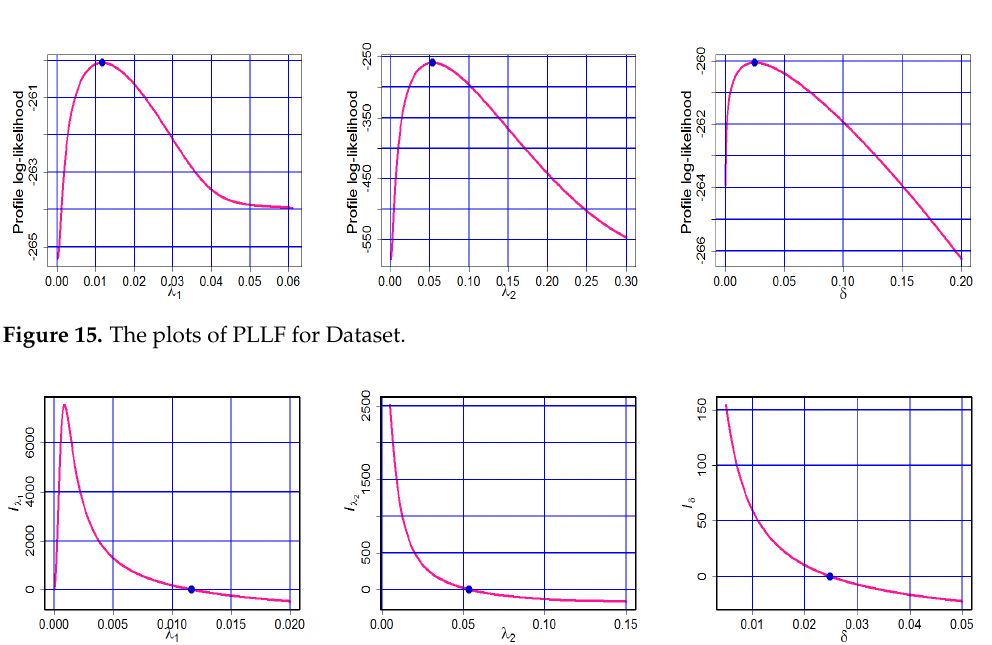
Figure 16. The graphs of score functions cross the horizontal axis at ˜ λ 1 , ˜ λ 2 , and ˜ δ of Dataset.